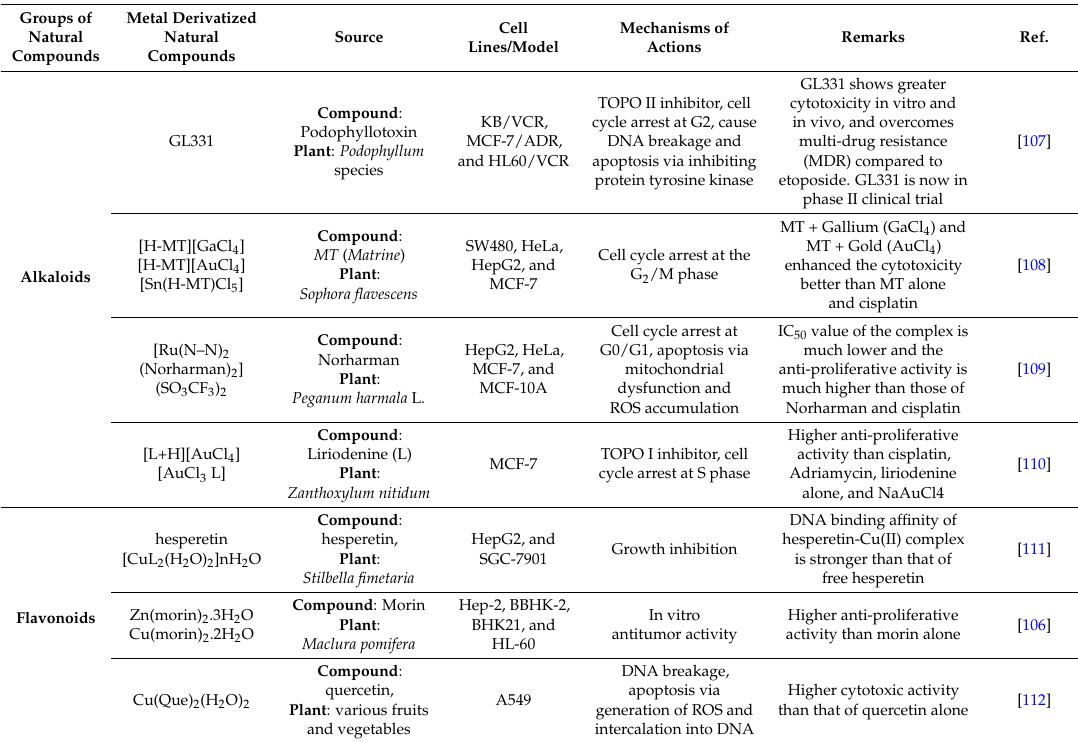
Table 2. Mechanisms of action of metal-derivatized natural compounds compared to their original forms and/or existing metal-based anticancer